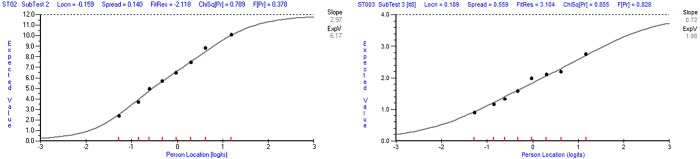
Item characteristic curve for Composite Item 2 (left) and Item 8 (right). Note. The x-axis indicates the latent trait and the y-axis indicates the item score. The black points represent the average observed item responses in each class interval. The grey logistic curve indicates the expected item responses. The slope of the Item Characteristic Curve indicates the rate of change of the expected value with respect to the latent trait at the mid-point between the minimum and maximum scores.